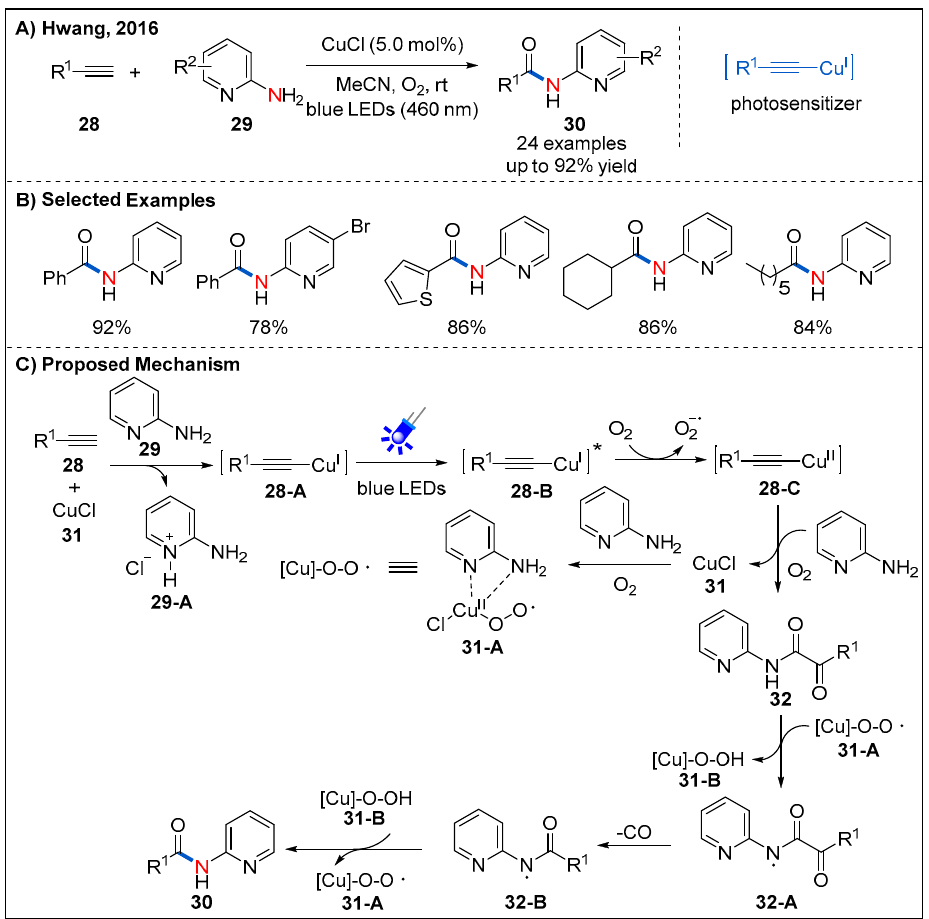
Figure 12. Visible-light-mediated oxidative C–N coupling.